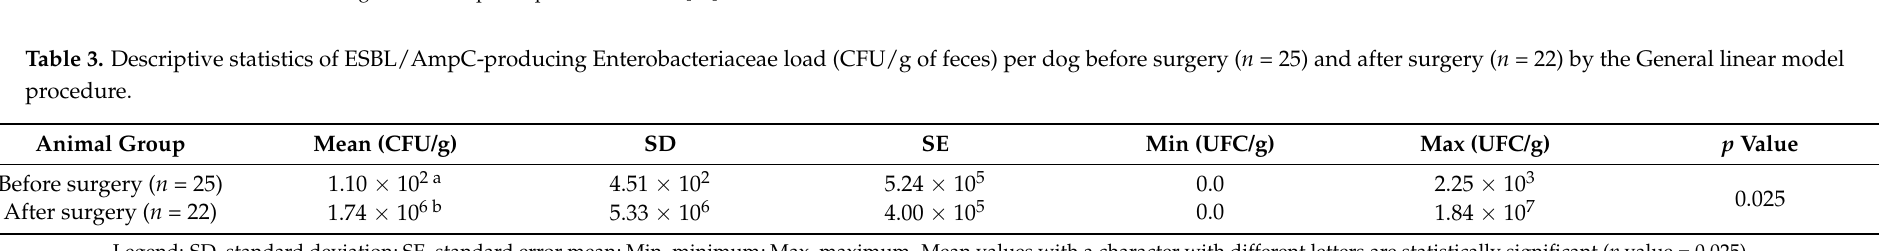
Before surgery ( n = 25)